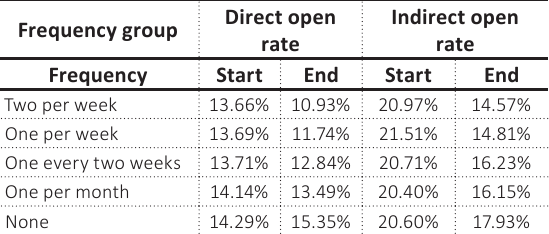
Table 2. Start-end-comparison of direct open rate and indirect open rate per frequency